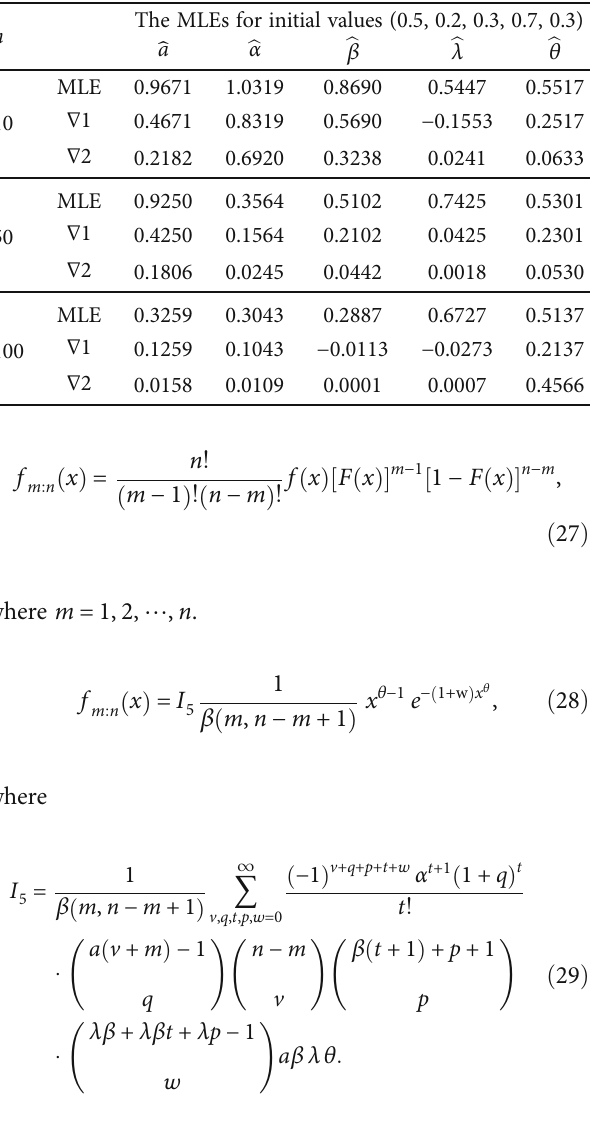
Table 3: The values of MLE, ∇ 1 , and ∇ 2 for the unknown parameters a , α , β , λ , and θ at (0.5, 0.2, 0.3, 0.7, and 0.3), respectively.